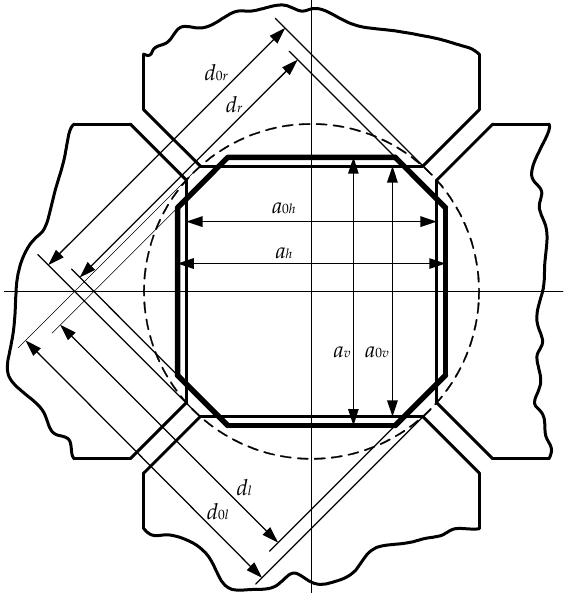
Figure 5. Explanations for Deriving the Longitudinal Geometry Variation Equations.